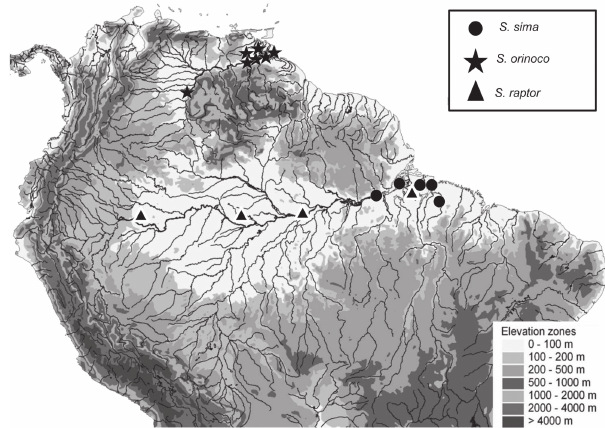
Fig. 19. Map of collection localities for specimens in the S. sima group. Sternarchella sima (circles), S. orinoco (stars), and S. raptor (triangles). Note most specimens of the S. sima group have been collected near the mouths of the Amazon and Orinoco rivers.